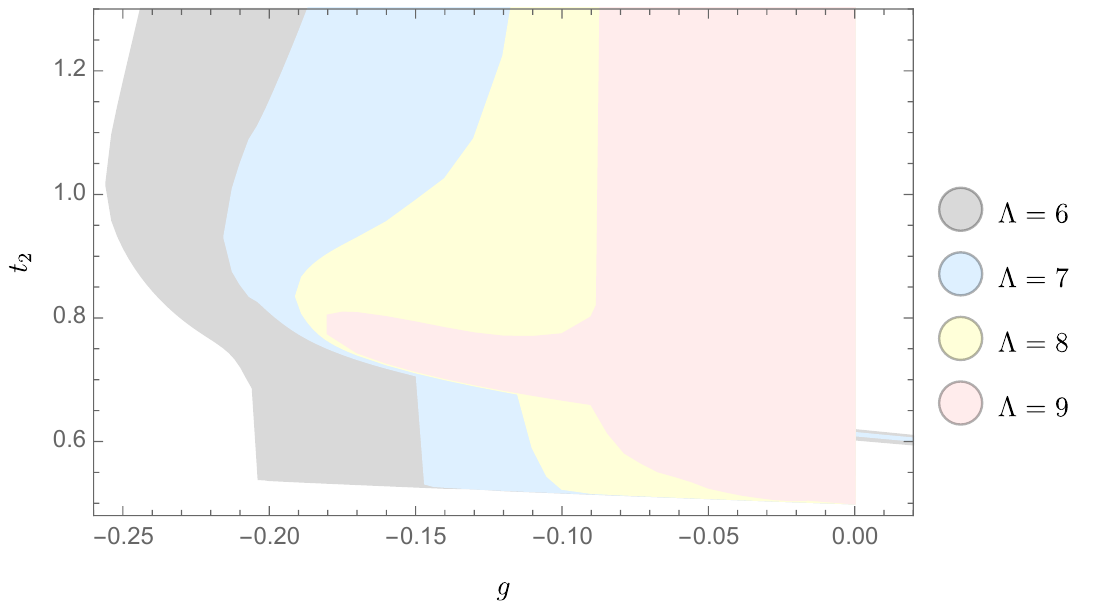
Figure 9 . The allowed region for the fixed h = 1 and varying g . For the lower bound of the pink region Λ = 9 , there are some numerical instabilities at − 0 . 09 < g < 0 . From careful inspection of our data at various values of Λ it seems that the lower bound at Λ = 9 should stabilize in this region at the value t 0 . 5 if no numerical instabilities happened in our SDP 2 ’